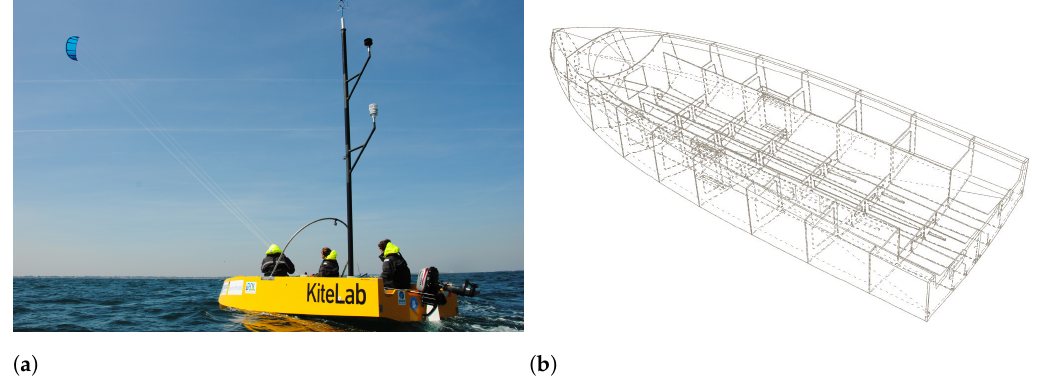
Figure 2. ( a ) Kiteboat wind measurement experimental set-up based on three sonic anemometers located at different altitude above sea level. ( b ) Overview of the plywood structure of the